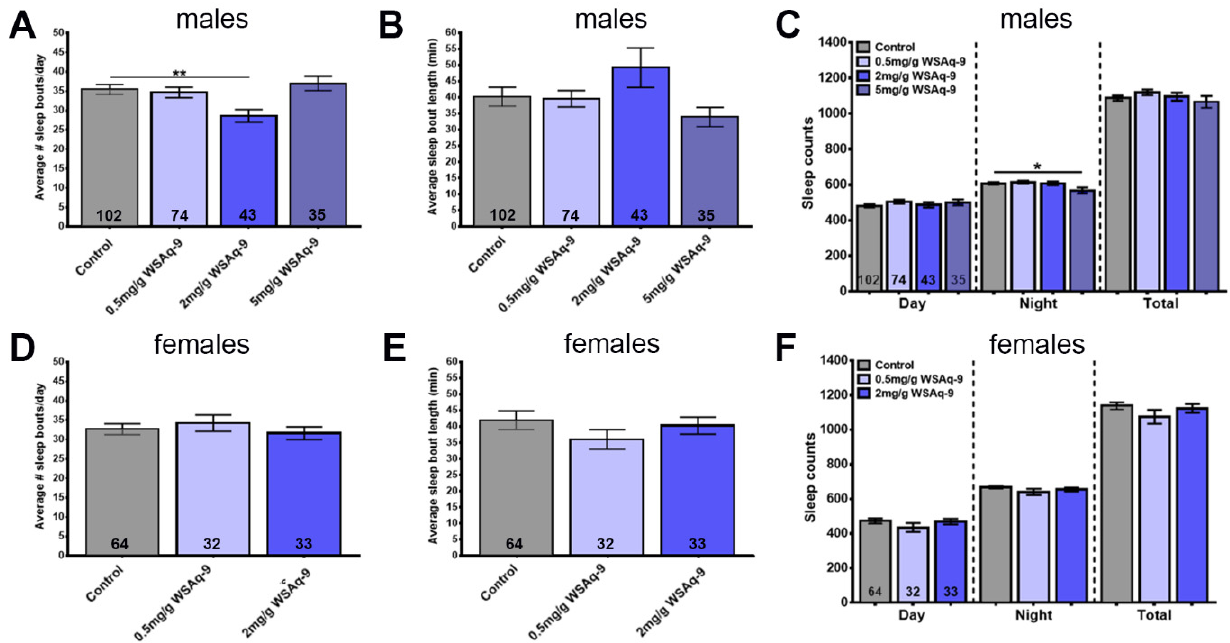
Figure 5. WSAq-9 does not improve sleep. Males show a reduction in sleep bout number with 2.0 mg/g WSAq-9 ( A ) but no significant increase in sleep bout length ( B ). Daily sleep time is not affected by WSAq-9 supplementation, with the exception of a reduction in nighttime sleep in males treated with the highest dose of 5.0 mg/g ( C ). WSAq-9treatment does not cause any changes in sleep pattern and time in females ( D – F ). Sleep was analyzed from age 42 d to 50 d. A one-way ANOVA l with Dunnett’s multiple comparisons test was used, and the number of analyzed flies is given in the bars. Bars represent means and error bars SEMs. * p < 0.05, ** p < 0.01 compared to controls on regular food.